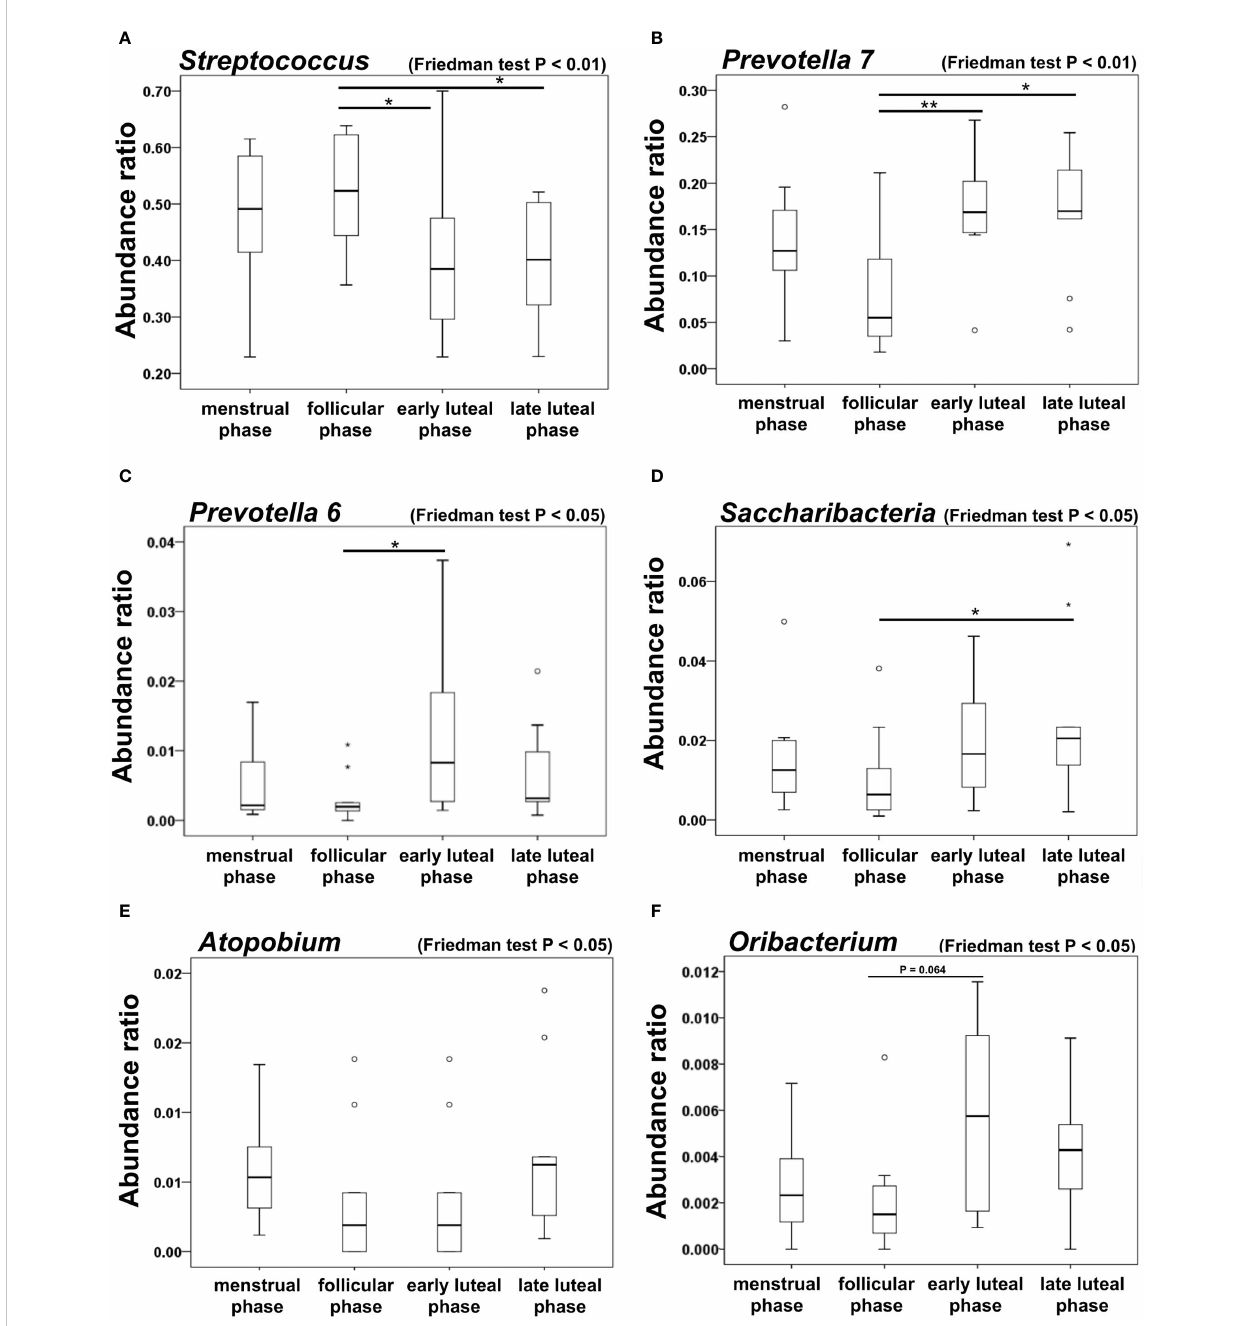
FIGURE 2 Abundance ratios of each bacterial genus in the oral microbiome offemale subjects. Boxplots showing the abundance ratios of each bacterial genus during menstrual cycles: (A) Streptococcus genera. (B) Prevotella 7 genera. (C) Prevotella 6 genera, (D) Saccharibacteria genera, (E) Atopobium genera, and (F) Oribacterium genera (menstrual, follicular, early luteal, and late luteal phases). Friedman test and Bonferroni test, * P < 0.05 and ** P < 0.01. N =